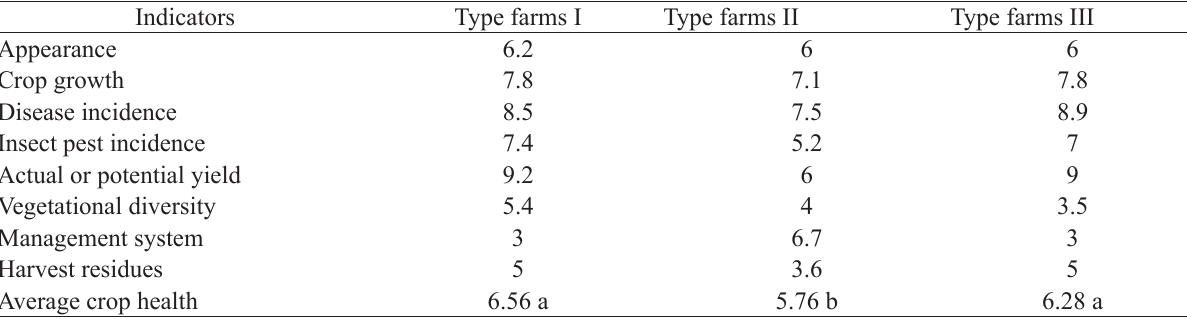
Table 3. Crop health of “type farms” with cacao in Huicungo (San Martín)